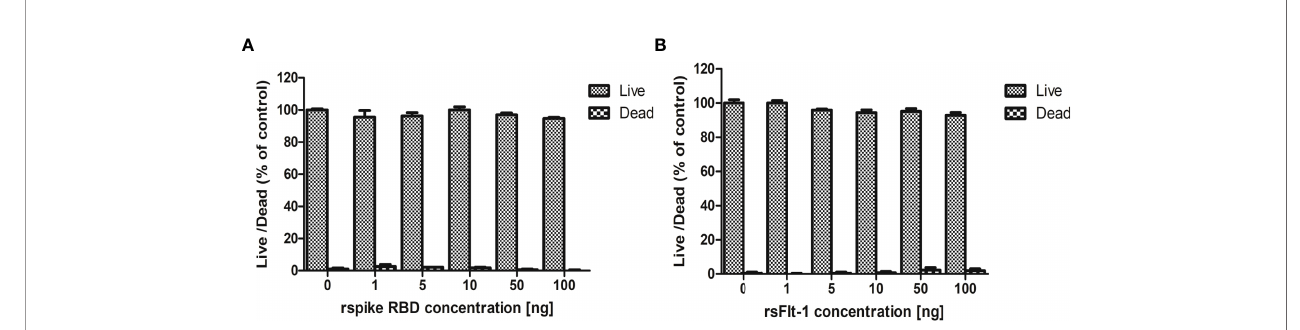
FIGURE 5 | Assessment of cytotoxicity of rspike RBD and rsFlt-1: (A) A549 cells treated with rsFlt-1 or (B) rspike RBD at 1, 5, 10, 50, 100 ng revealed no signi fi cant cytotoxic effect on treated cells compared to control. The experiment was performed in triplicate; SD and error bars are depicted in the graph. and rsFlt-1 proteins by pre-incubation and probed with either anti- receptors, spheroid probed with anti-sFlt-1 antibody ( Figure 8F ), VEGF or anti-Flt-1 antibody lack fl uorescence signals and con fi rm VEGF ( Figure 8G ), or anti-VEGF antibodies ( Figure 8H ) used as a the capture of VEGF receptors by sFlt-1 protein (negative control positive control and revealed high-intensity immuno fl uorescence - Figures 8I, J ). signals on 3D-spheroids. Spheroids treated with interacted rVEGF